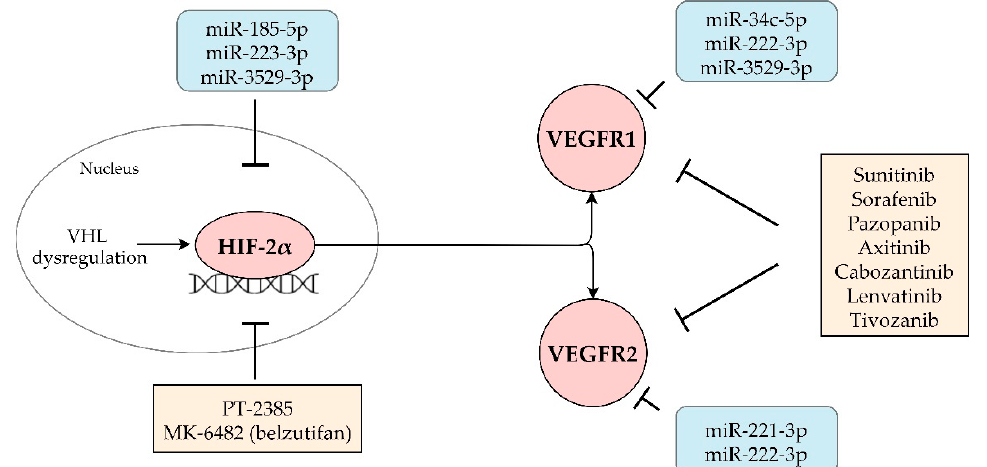
Figure 4. Through targeting HIF-2 α , VEGFR1 and/or VEGFR2, miRNAs can deplete the drug targets of HIF-2 α inhibitors and/or VEGFR-TKIs and lead to therapeutic resistance. Abbreviations: HIF-2 α = hypoxia-induced factor- 2 α , VEGFR1 = vascular endothelial growth factor receptor 1, VEGFR2 = vascular endothelial growth factor receptor 2, miRNA = microRNA, VEGFR-TKIs = vascular endothelial growth factor receptor tyrosine kinase inhibitors, miR = microRNA.